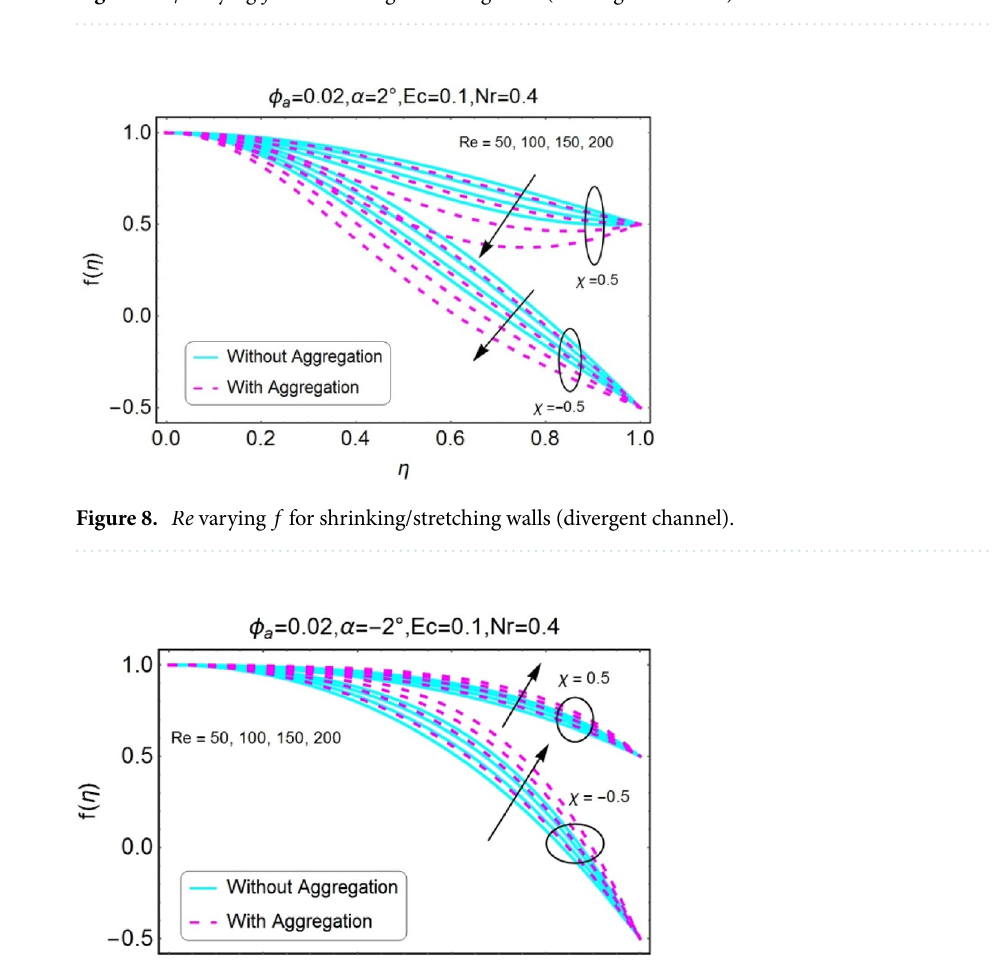
Figure 7. φ varying f for shrinking/stretching walls (convergent channel).